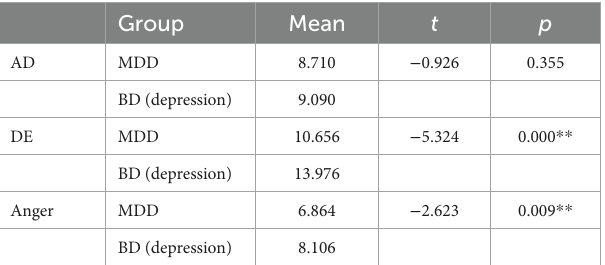
TABLE 6 Comparison of AD, DE, and Anger between MDD ( n = 221) and depressive episode of bipolar disorder ( n = 86). Group